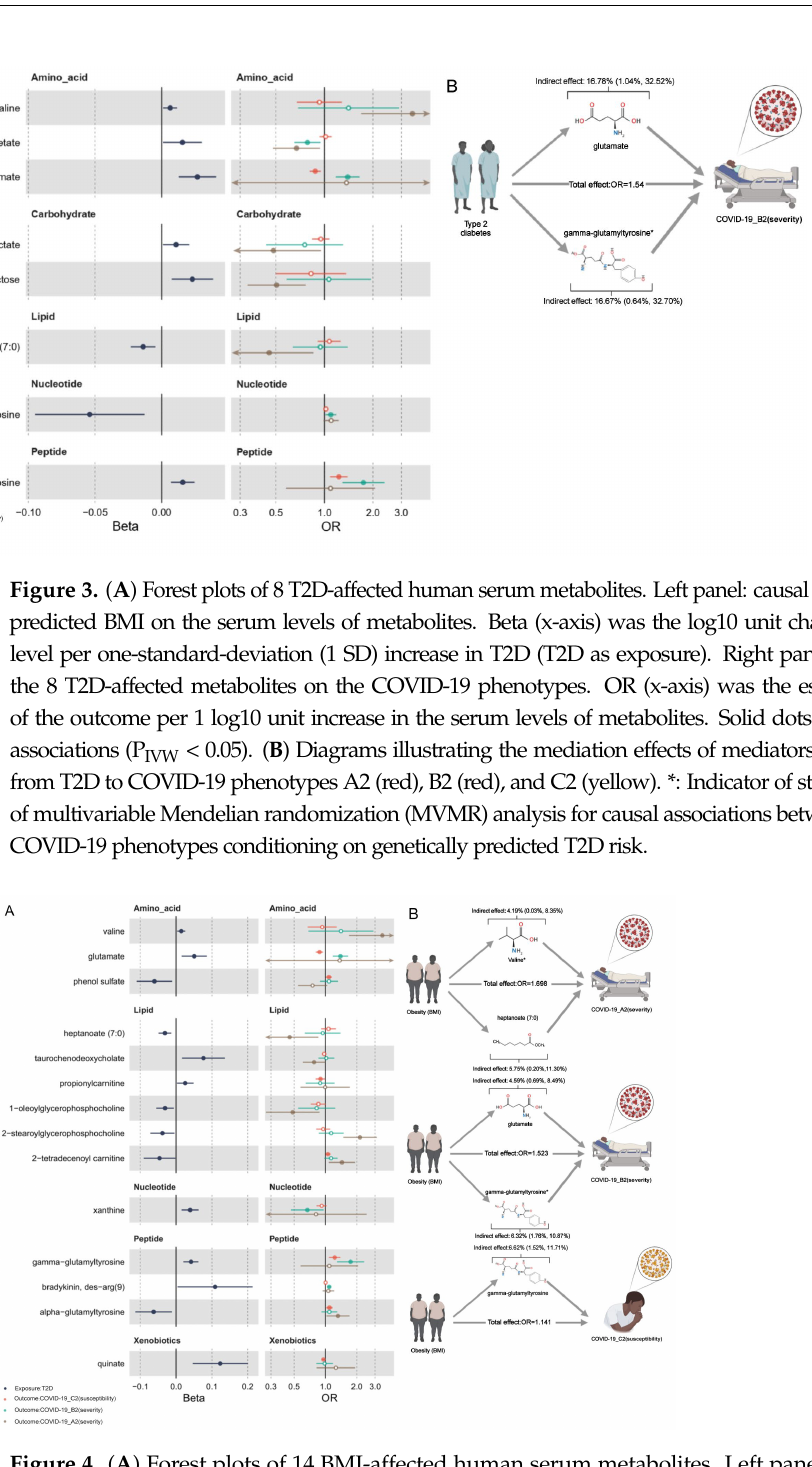
Figure 4. ( A ) Forest plots of 14 BMI-affected human serum metabolites. Left panel: causal effects of genetically predicted BMI on the serum levels of metabolites. Beta (x-axis) was the log10 unit changes of metabolite level per one-standard-deviation (1 SD) increase in BMI (BMI as exposure). Right panel: causal effects of the 14 BMI-affected metabolites on the COVID-19 phenotypes. OR (x-axis) was the estimated odds ratio of the outcome per 1 log10 unit increase in the serum levels of metabolites. Solid dots indicate significant associations (P IVW < 0.05). ( B ) Diagrams illustrating the mediation effects of mediators on the causal path from obesity to COVID-19 phenotypes A2, B2 and C2. *: Indicator of statistical significance of multivariable Mendelian randomization (MVMR) analysis for casual associations between mediators and COVID-19 phenotypes conditioning on BMI.